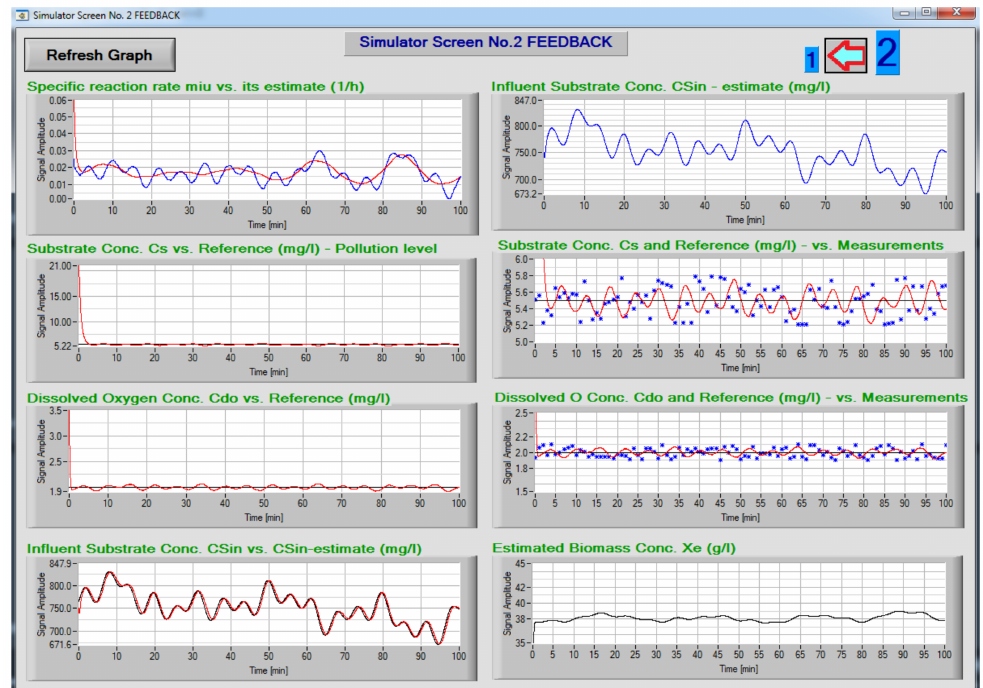
Figure 10. Closed-loop emulator of the adaptive controlled ASP—first screen, with several knobs and graphs for the visualization of the main variables’